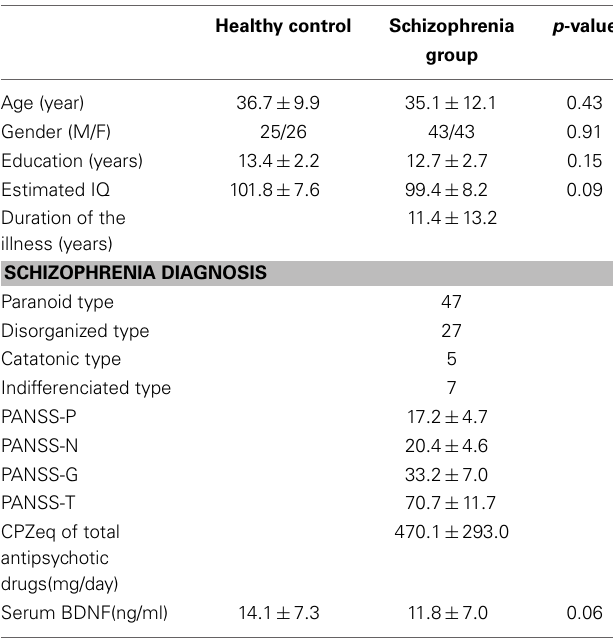
Table 1 | Demographic and clinical information of the schizophrenia patients and the healthy control